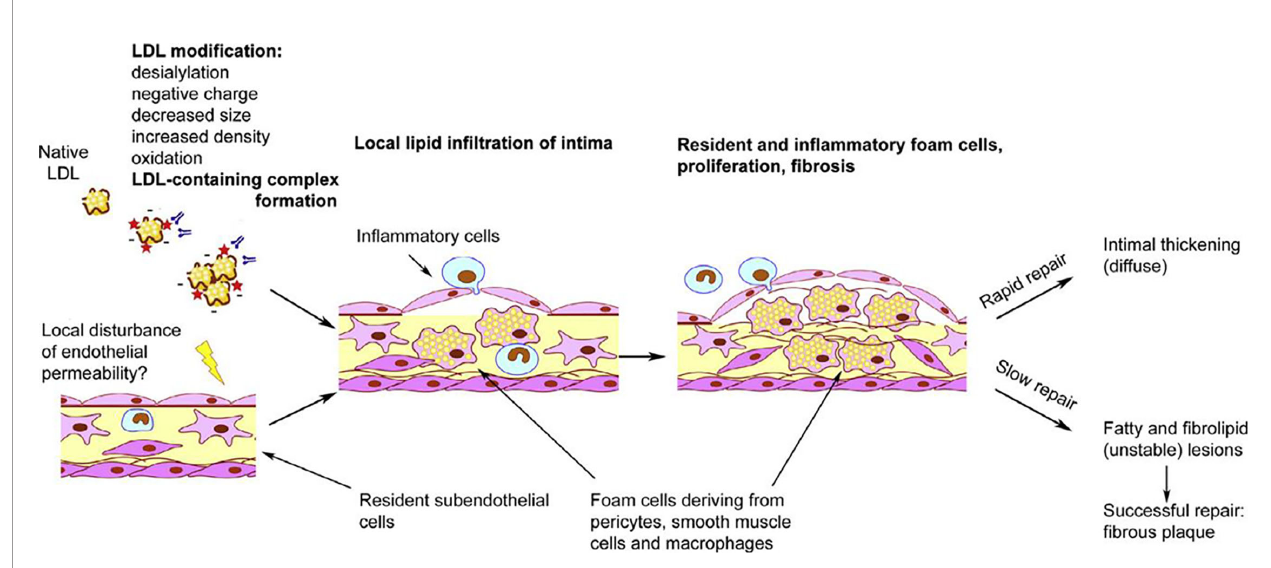
FIGURE 1 | Schematic overview of initiation of atherosclerotic lesion formation. From Orekhov and Ivanova (2016), with